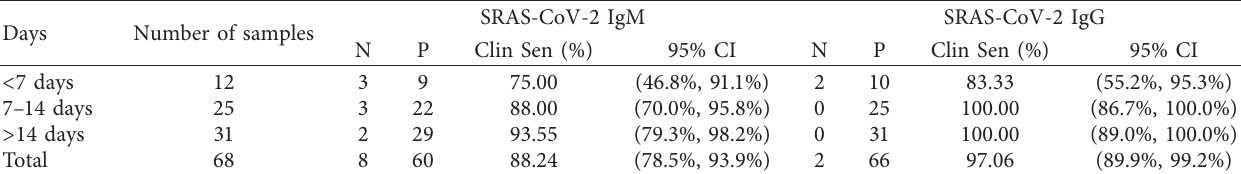
Table 2: Clinical sensitivity of SARS-CoV-2 IgM and SARS-CoV-2 IgG.